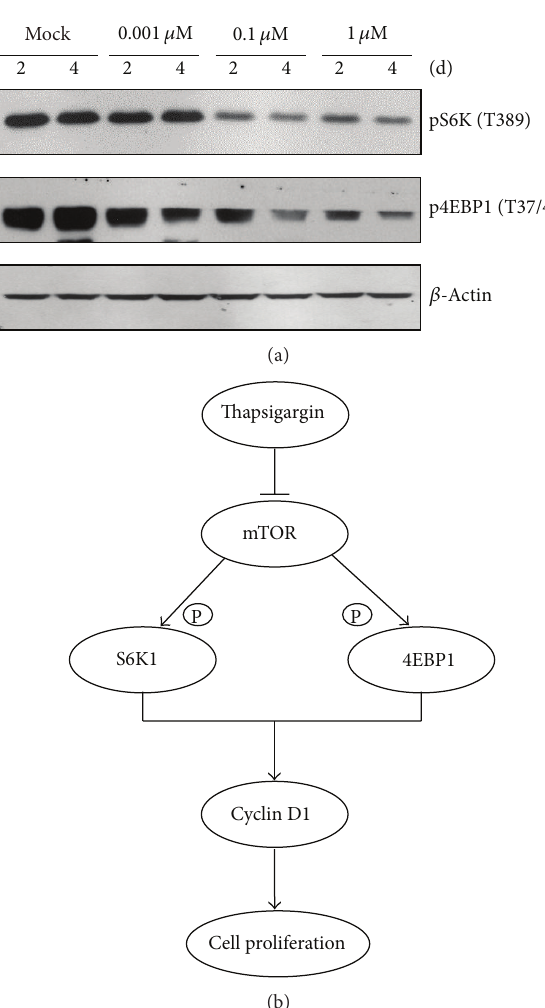
Figure 4: Thapsigargin inhibits cyclin D1 expression through mTOR pathway. (a) Western blots showing that the protein levels mTOR downstream markers pS6K and p4EBP1 were decreased in MH7A cells by thapsigargin treatment. (b) A scheme model highlighting that thapsigargin impairs cyclin D1 expressions by mTOR pathway and finally leads to disrupted cell proliferations and survivals in MH7A human rheumatoid arthritis synovial